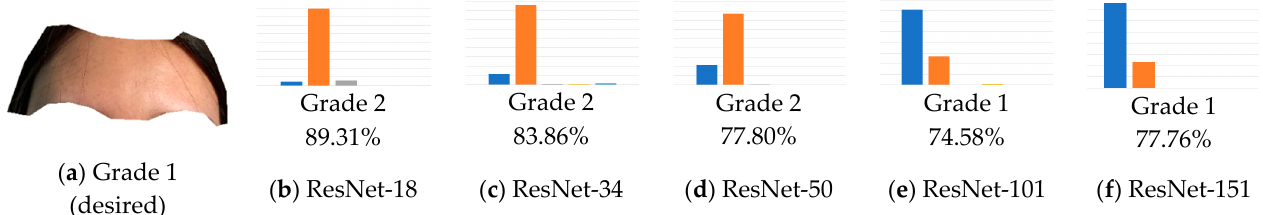
Figure 8. Example and training results of Grade 1 forehead wrinkles (wrongly classified grades are underlined).